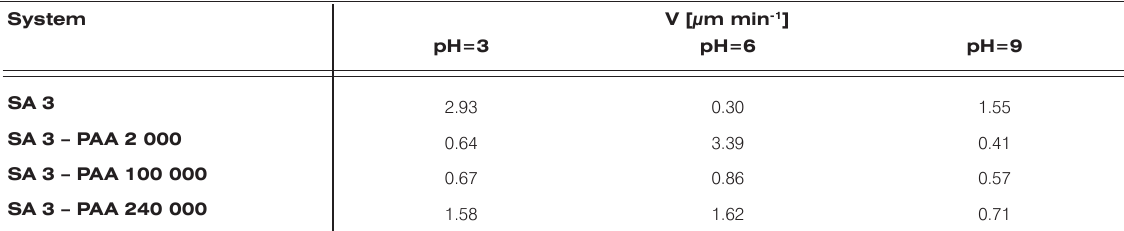
Table 3. The average velocity of aggregates (flocs) sedimentation in SA 3 suspension in the absence and presence of polyacrylic acid.